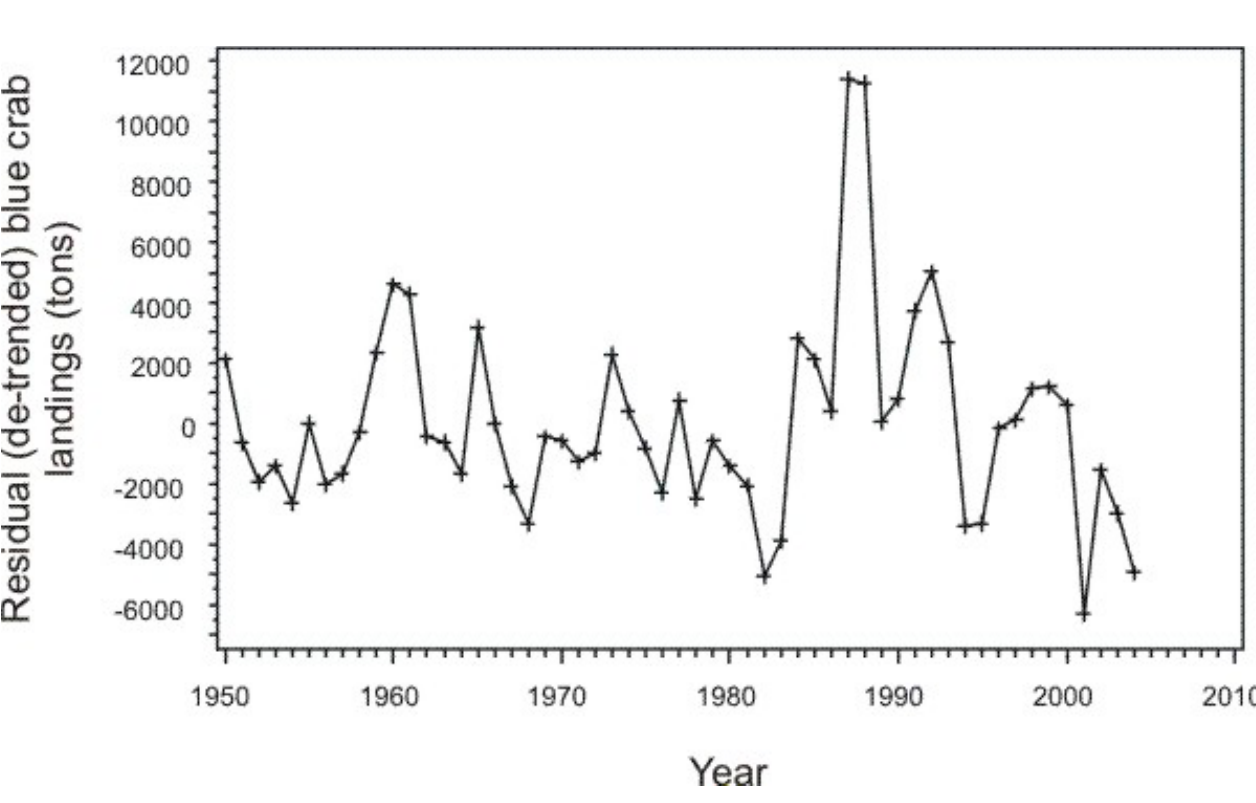
Fig. 6. Detrended blue crab landings for